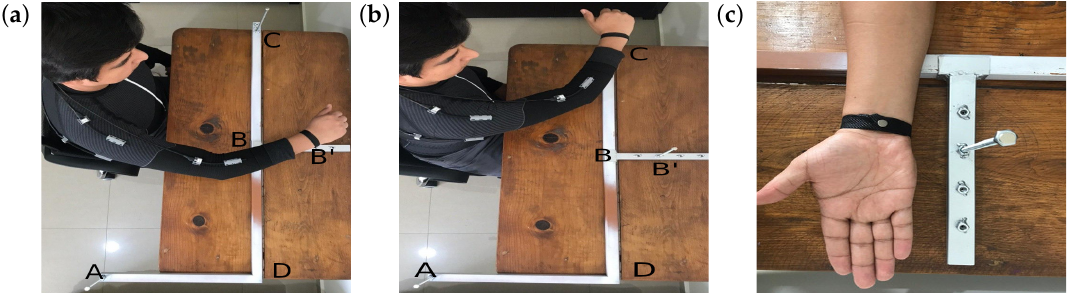
Figure 6. Calibration frame top view. ( a ) Shows arm pose at the point B of the frame to estimate the length of the arm and forearm with a known distance AB . ( b ) Gesture performed for redundant calculation towards point C . ( c ) It shows the bracelet tight and a magnet to guarantee the same pose of the wrist with the pin on the frame.